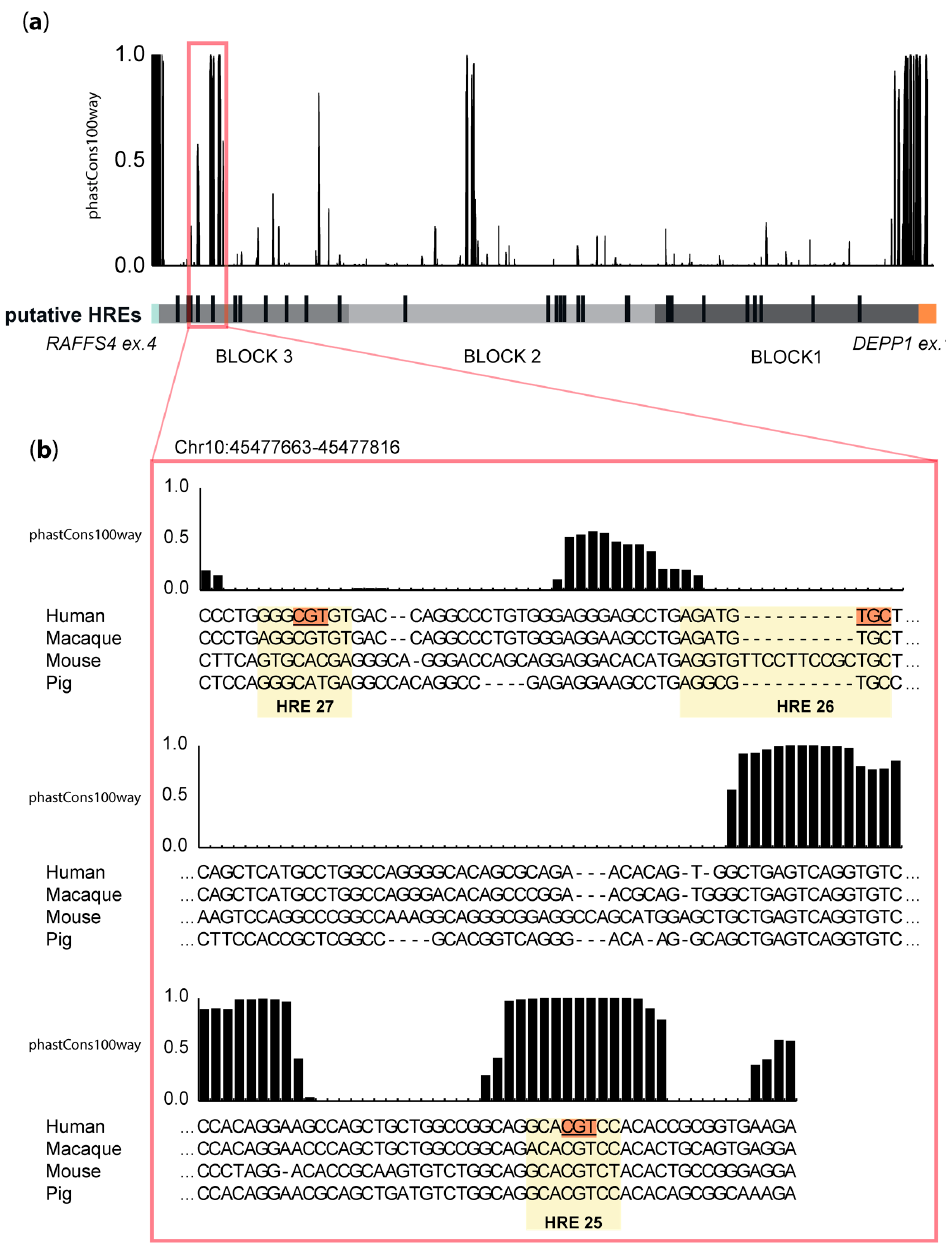
Figure 5. Analysis of DNA sequence conservation upstream of DEPP TSS. ( a ) Schematic representation of the 3.8 kb region analyzed (chr10:45474246-45478004 on the hg19 build), divided in three blocks (bottom). The putative HREs are indicated by black lines, whilst the three blocks are shown in different tones of grey. The plot on top of the region shows the corresponding conservation score (phastCons100way). A value of 1.0 indicates 100% conservation across the species tested. ( b ) Detailed view of the region containing HREs 25–27, which were identified as being responsible for the hypoxic induction DEPP transcription (chr10:45477663-45477816 on the hg19 build). The human sequence (hg19) was aligned to the homologous region of rhesus macaque (Macaca mulatta, rheMac3), mouse (Mus musculus, mm10 build), and pig ( Sus scrofa , susScr3). The putative HREs identified in this region are highlighted in light yellow and their core sequence underlined and highlighted in orange. On top of each nucleotide, the plot displays the corresponding conservation score (phastCons100way).